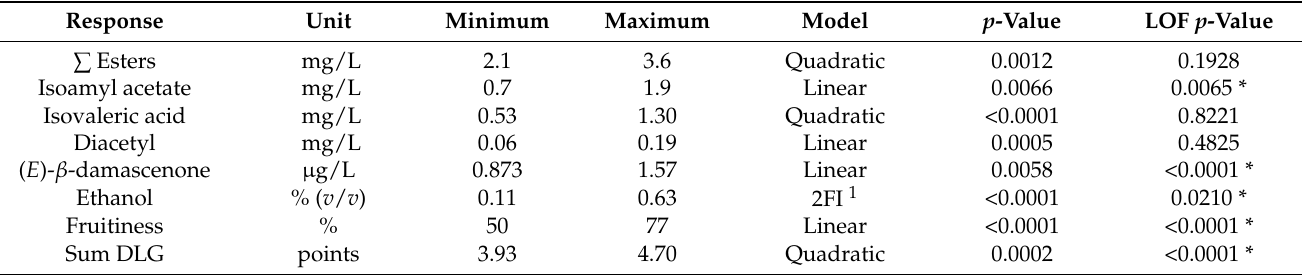
Table 3. Analysis of variance (ANOVA) of selected responses using the three factors A: Temperature ( ◦ C), B: Original Gravity ( ◦ P), C: Pitching Rate ( × 10 6 cells/mL) for response surface methodology